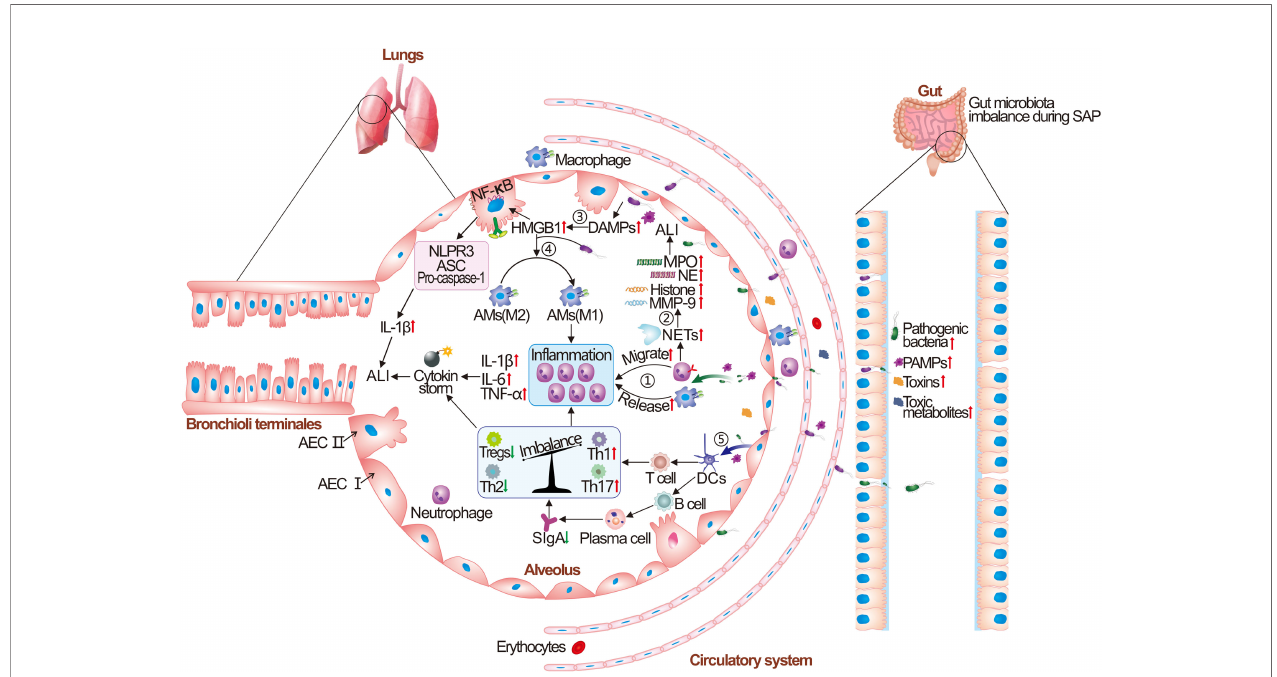
FIGURE 4 | The pathogenesis of intestinal microbiota dysbiosis caused acute lung injury (ALI). Brie fl y, the intestinal pathogenic bacteria and harmful metabolites are translocated to the lung and recognized by pulmonary innate immune cells (AECs, AMs, DCs, and NK cells). Then, the release of persistent pro-in fl ammatory cytokines is induced by binding to their pattern recognition receptors (PRRs) on the cell surface, causing an “ in fl ammatory storm ” . A large number of neutrophil cells aggregate in the alveoli and neutrophil extracellular trap network (NETs) lead to increased release of neutrophil elastase (NE), myeloperoxidase (MPO), and histone. The in fl ammatory factors, granulins, and in fi ltrated red blood cells from vascular cause the damage and hemorrhage of lung tissue. Subsequently, the lung tissue initiates the immune responses of damage-associated molecular patterns (DAMPs), causing increased release of high mobility group protein B1 (HMGB1), the abnormal polarization of M1-type macrophages, and release of NOD-like receptor thermal protein domain associated protein 3 (NLRP3). Finally, lung tissue initiates an adaptive immune response, and increased production of pro-in fl ammatory Th1 and Th17 immune cells and suppression of Tregs cells could be observed, resulting in the paralysis of the immune system and irreversible ALI. AECs, alveolar epithelial cells; AMs, alveolar macrophages; DCs, dendritic cells; ASC, Apoptosis-associated speck-like protein containing a caspase recruit domain; SIgA, secretory